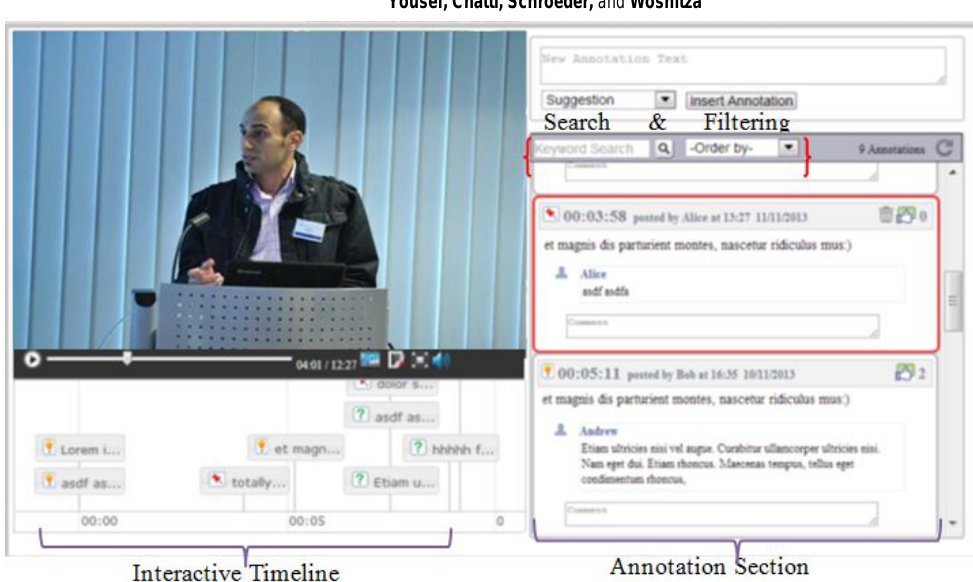
Figure 3. L 2 P-bMOOC Video Annotation